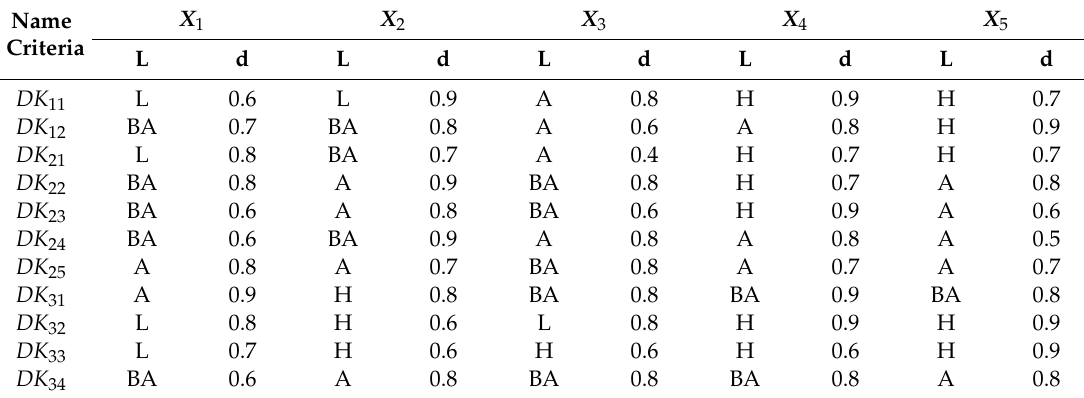
Table 3. Inputs of developers of environmental start-up projects on the criteria of evaluation.